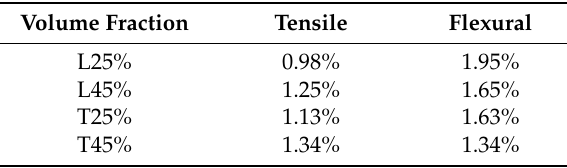
Table 5. Failure Strain for the Tensile and Flexural